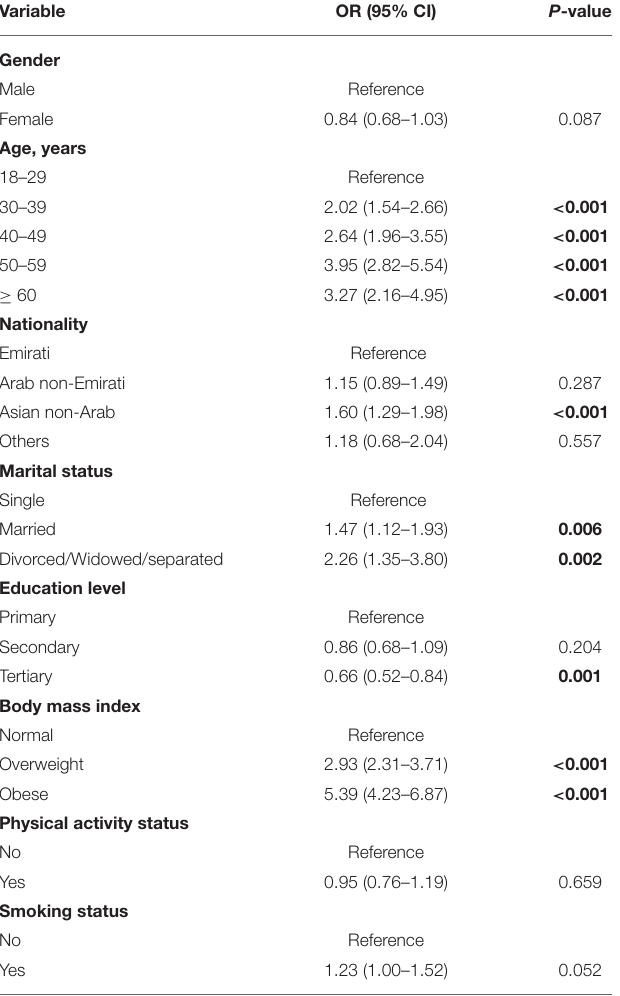
TABLE 3 | Binary logistic regression model for the predictors of metabolic syndrome in whole UAE residents, OR (95% CI).